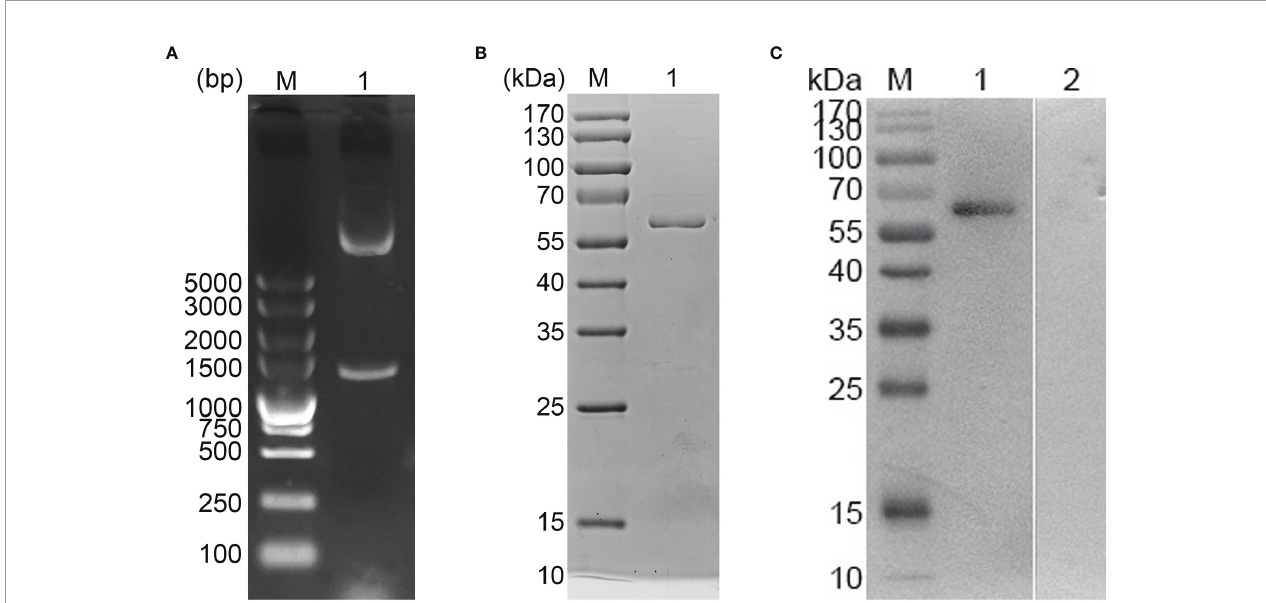
FIGURE 2 | (A) Double digestion analysis. Line M: DL5,000 marker; Line 1: Double digestion of the constructed pET-32a-Em1a plasmid by Kpn I and Eco RV. (B) SDS-PAGE analysis. Line M: Molecular weight (MW) marker proteins. Line 1: puri fi ed Em1a proteins. (C) Western blot analysis of puri fi ed Em1a proteins. Line M: MW marker proteins. Line 1: Puri fi ed Em1a proteins were detected by sera from E mitis -infected chickens; Line 2: Puri fi ed Em1a proteins were detected by sera from control chickens.